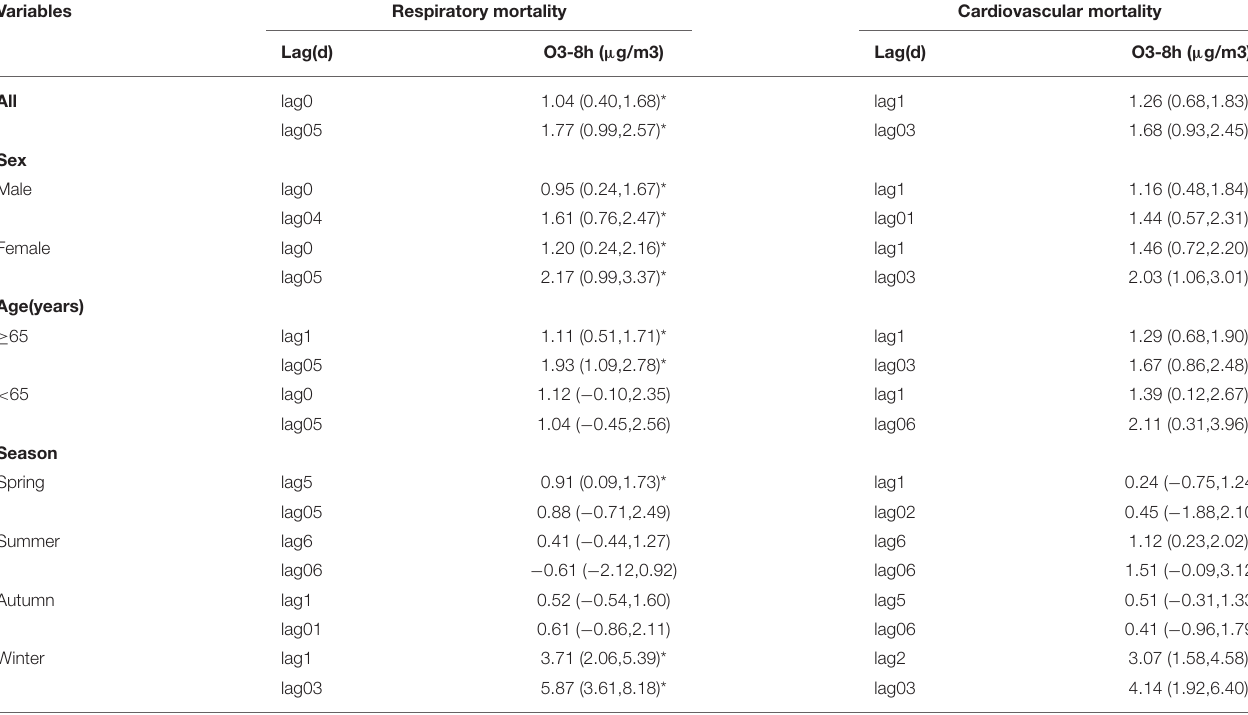
TABLE 4 | The ER (95%CI) of respiratory mortality and cardiovascular mortality in the optimal lag days for different age, sex and season.